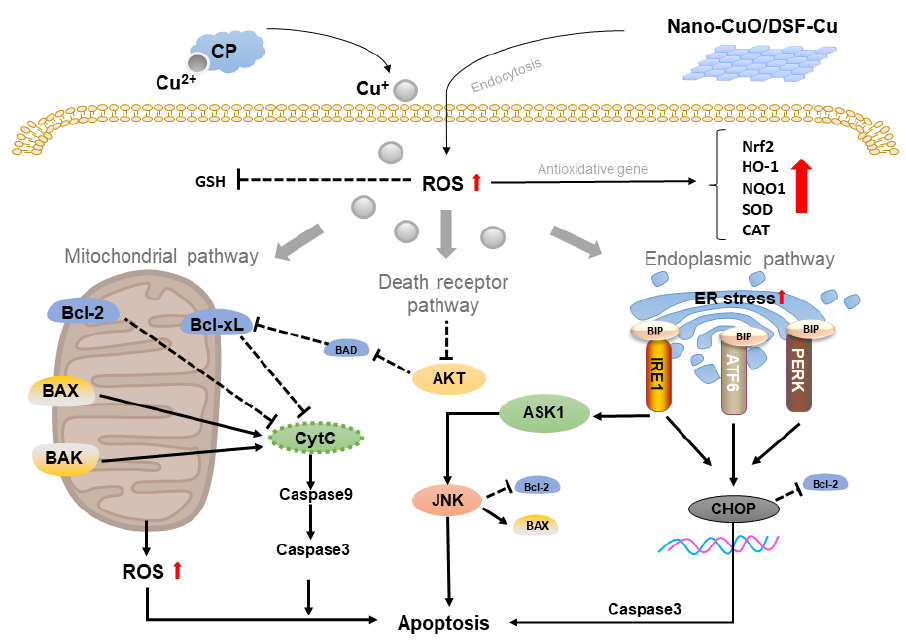
Figure 1. Schematic representation of copper-based apoptosis.